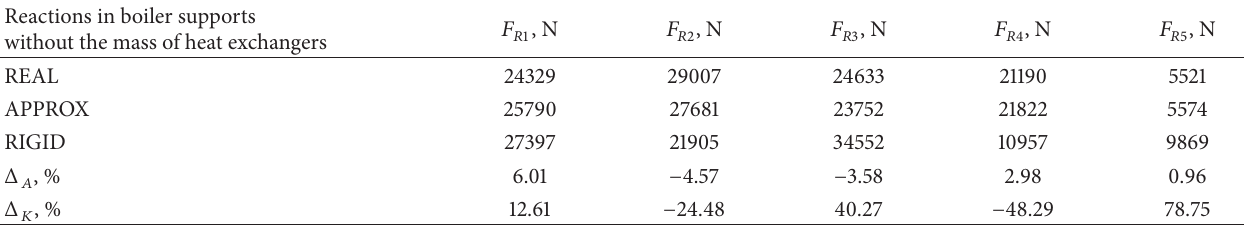
Table 7: Reactions in the boiler supports for the influence of mass of boiler without the mass of heat exchangers. Reactions in boiler supports